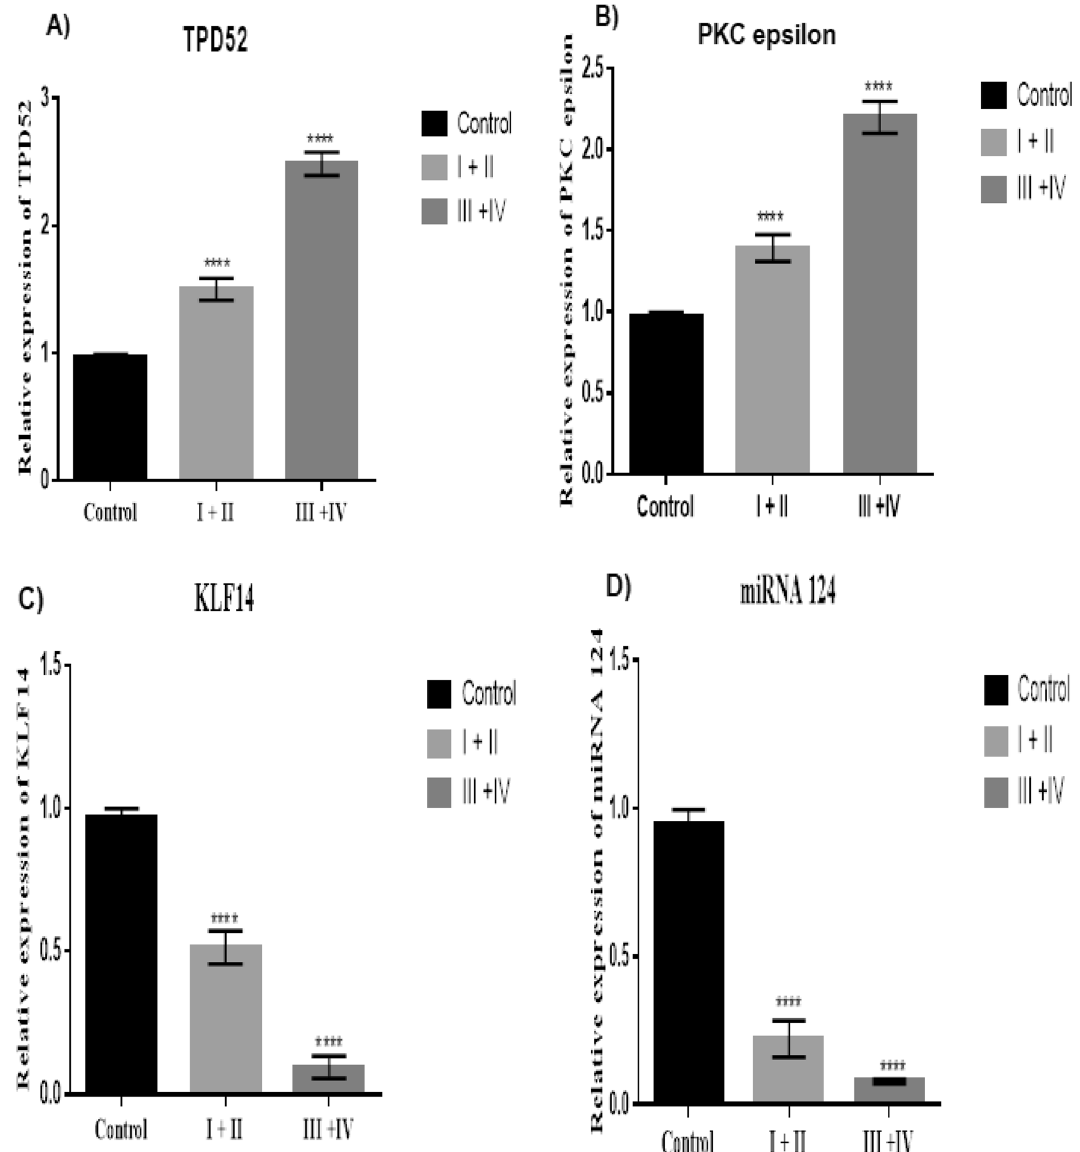
Figure 2. Expression of TPD52, PKCε, KLF14 and miRNA124 in relation to tumor grade of brain cancer. ( A ) Expression of TPD52 in grade I + II and III + IV compared to healthy controls; ( B ) Expression of PKCε in grade I + II and III + IV patients compared to healthy controls; ( C ) Expression of KLF14 grade I + II and III + IV patients compared to healthy controls; ( D ) Expression of miRNA 124 in grade I + II and III + IV compared to healthy controls; Representative data are presented as mean ± SEM of triplicate experiments. Statistical significance was measured by one way Anova (**** P < TPD52, PKCε, KLF14 and miRNA-124 expression with tumour grade, metastasis in brain can- cer. Evaluation of gene expression levels for TPD52, miR-124, PKCε and KLF14 with respect to cancer grade was performed (Table 2). These genes showed an association with tumour grade ( P < 0.0001). In the advanced grade group, there was higher expression of TPD52 and PKCε as compared to lower grade group (Fig. 2A, B, respectively). KLF14 and miR-124 showed low expression in advanced grade groups as compared to lower grade groups (Fig. 2C, D respectively). Differential expression of these understudied genes in relation to primary and secondary metastatic status of brain cancer was also investigated (Table 2). TPD52 and PKCε were observed to be highly expressed in the secondary metastatic group as compared to the primary metastatic group of brain cancer patients ( P < 0.0001) (Fig. 3A and Brespectively). Lower expression of KLF14 (Fig. 3C) and miR-124 (Fig. 3D) was observed in the secondary metastatic group compared to the primary metastatic group ( P = 0.0001, P < 0.0001 respectively). TPD52, miRNA-124, PKCε and KLF14 were evaluated for altered expression levels separately in male and female patient groups (Table 3). The expression of TPD52 and PKCε was higher while miR-124 and KLF14 was